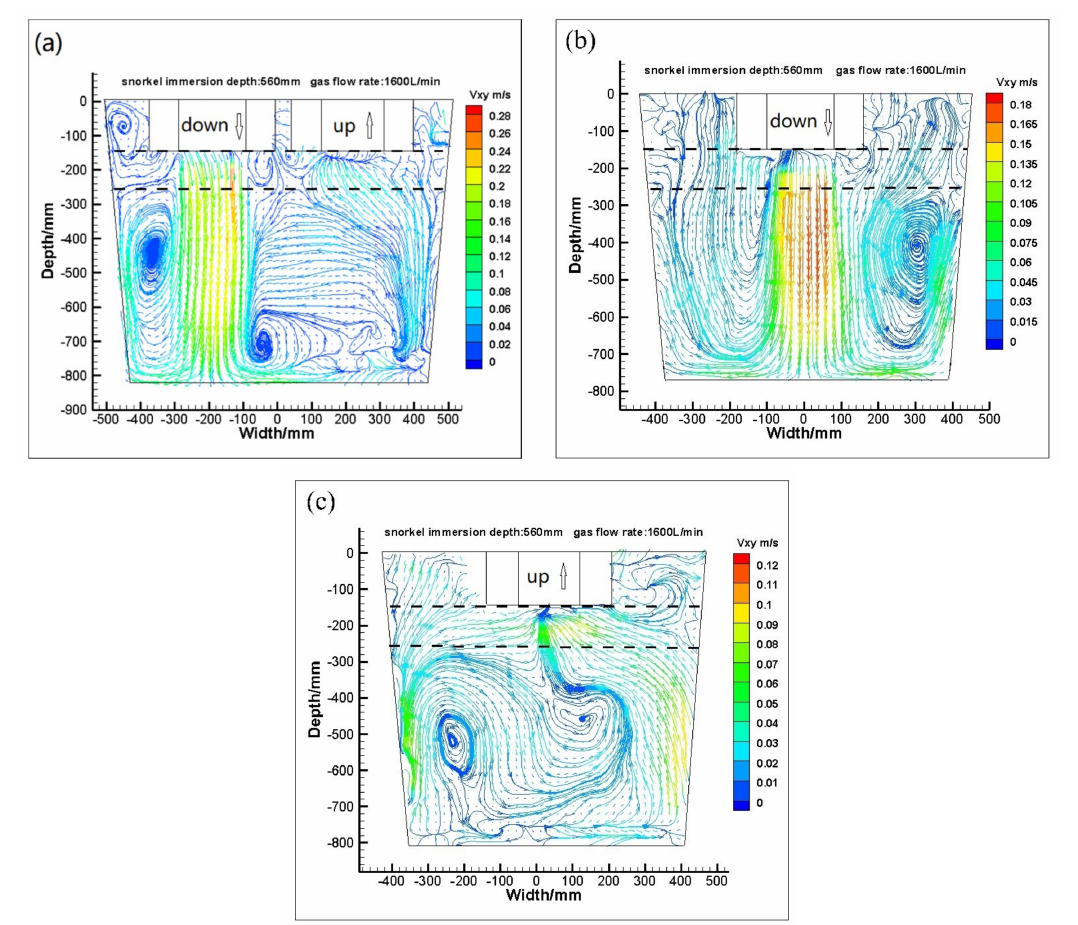
Figure 4. RH flow field by PIV system: ( a ) section of up-leg and down-leg; ( b ) section of down-leg; ( c ) section of